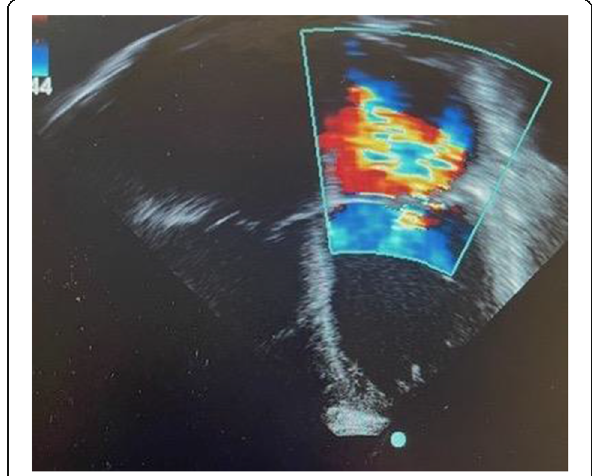
Fig. 4 Echocardiography showing dilated right atrium, dilated LV and slightly thickened mitral valve with no movement restriction. There was prolapse of the anterior leaflet of the mitral valve